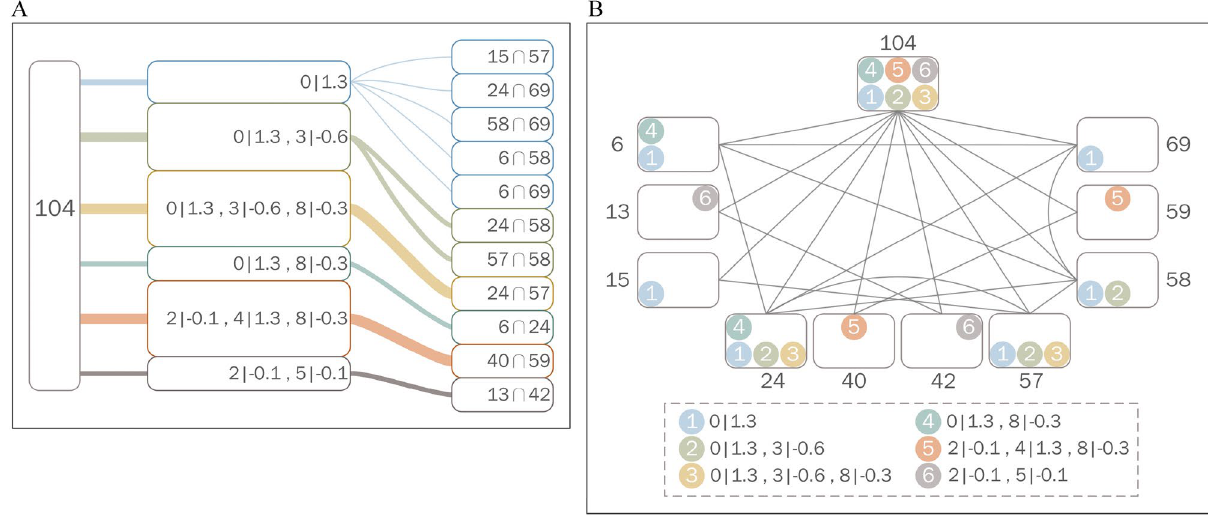
Figure 2. Association between patterns and observations in BCWO ( A ) at the ratio